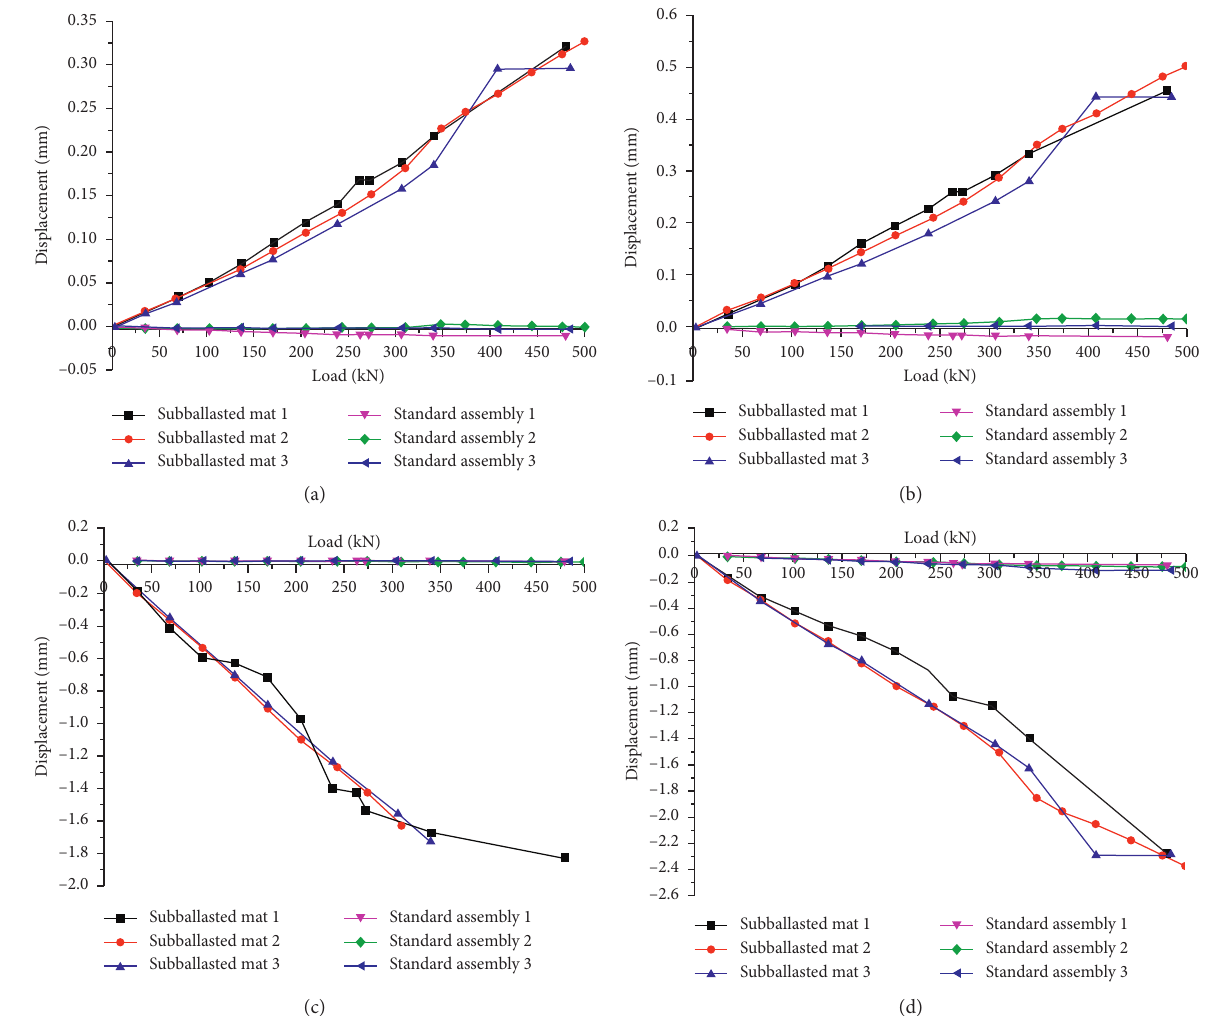
Figure 12: Interlayer deformations of the ballastless tracks loading at the slab center: (a) 1-1; (b) 1-2; (c) 2-1; (d)